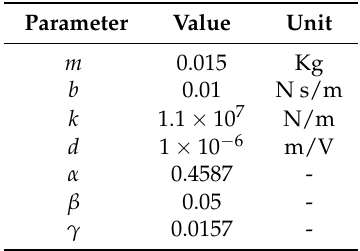
Table 1. Identified parameters of the system with the Bouc–Wen (BW) hysteresis model.